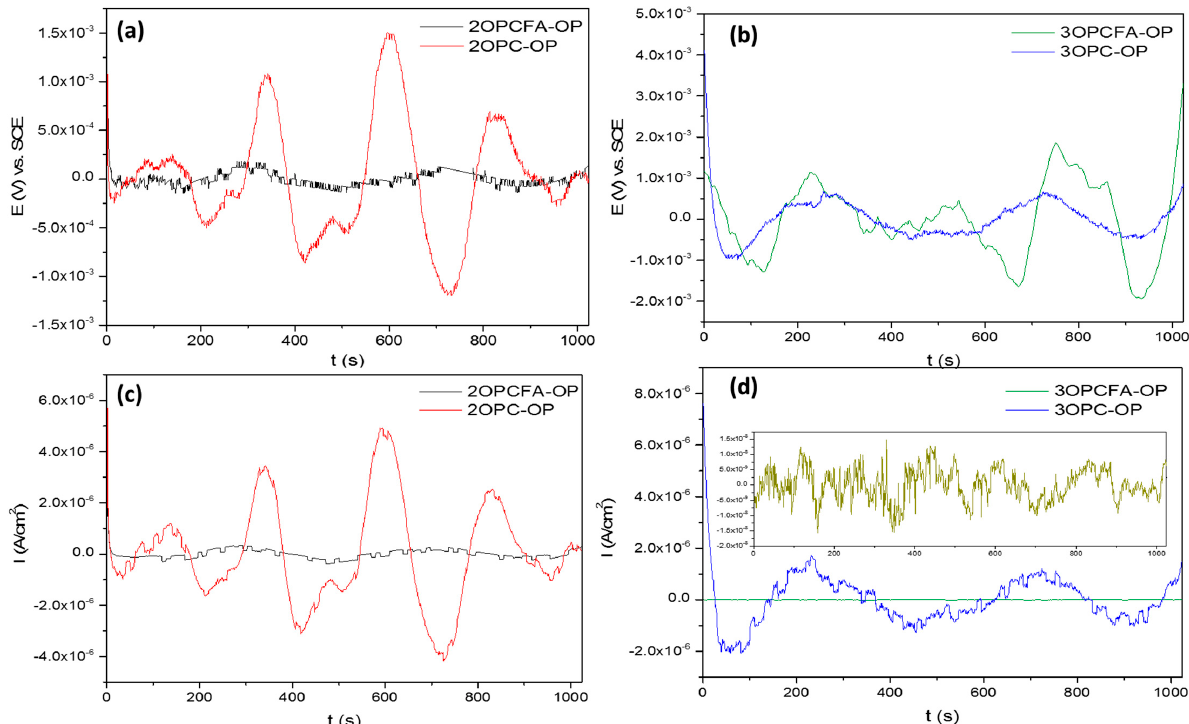
Figure 5. Electrochemical noise-time series for specimens subjected to Impressed current cathodic protection of reinforced concrete mixtures (OPC-OP and OPCFA-OP). ( a , b ) ENP, 2 and 3 months, ( c , d ) ENC, 2 and 3 months.